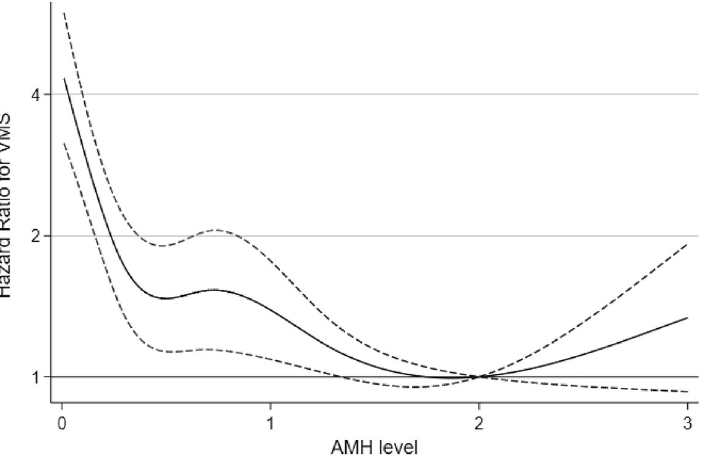
Figure 2. Multivariate-adjusted hazard ratios (95% confidence intervals) for incident early-onset vasomotor symptoms using AMH levels as a continuous variable. The curves represent adjusted hazard ratios (solid line) and their 95% confidence intervals (dashed lines) for incident early-onset VMS on the basis of restricted cubic splines for AMH levels with knots at the 5th, 27.5th, 50th, 72.5th, and 95th percentiles. The model was adjusted for age, education level, parity, physical activity, smoking status, alcohol intake, hypertension, lipid lowering agent and body mass